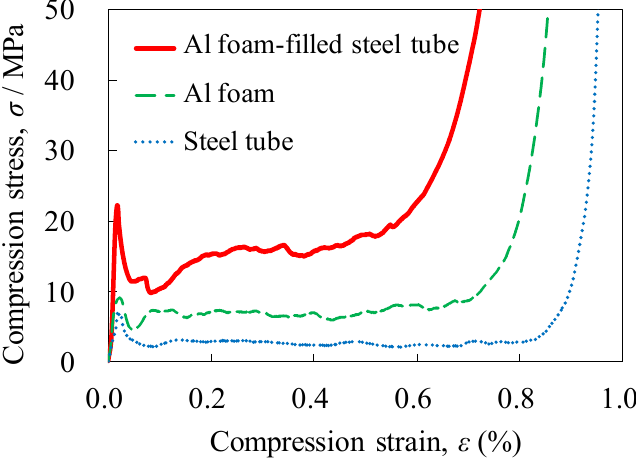
Figure 9. Stress–strain curves for fabricated Al foam-filled steel tube ( p = 83.3%) along with those for Al foam ( p = 85.9%) and steel tube.